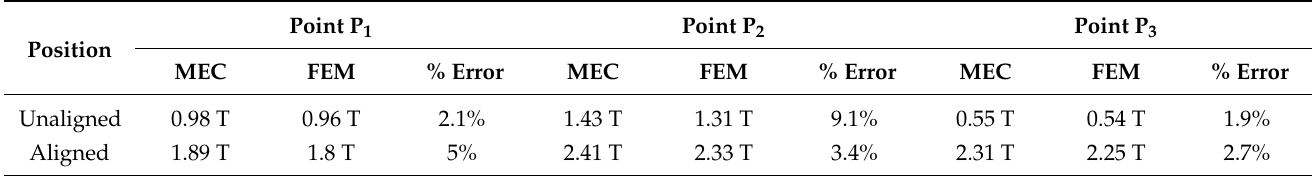
Figure 15. Magnetic flux density contours at 60 A static excitation current: ( a ) unaligned position, MEC, ( b ) unaligned position, FEM, ( c ) aligned position, MEC, and ( d ) aligned position, FEM. Table 9. Flux density comparison at points P 1 , P 2 , and P 3 in Figure 15 in static